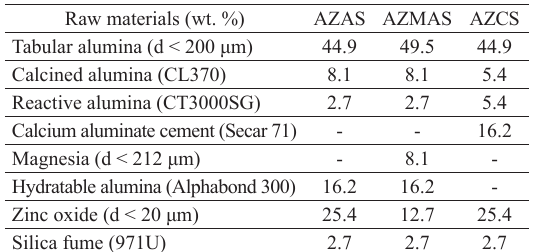
Table 2. Matrix (d < 200 μm) components of the castable’s